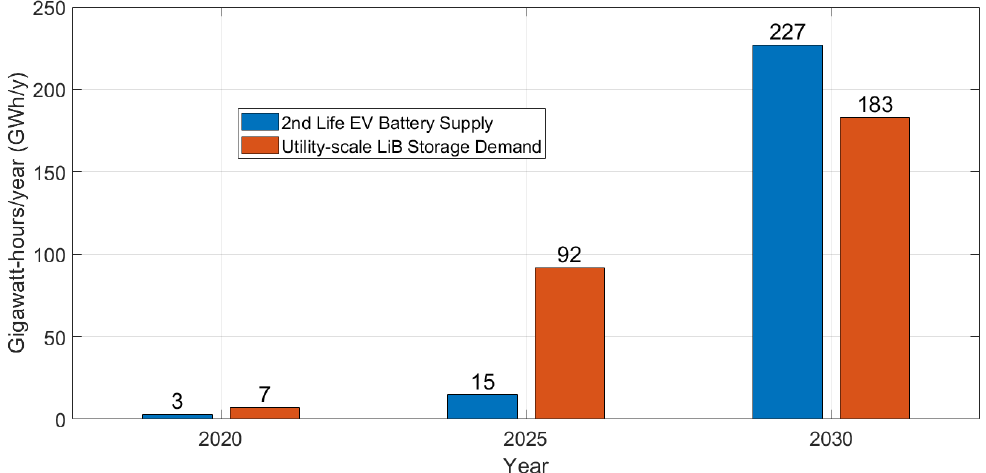
Figure 8. Estimated SLB from passenger car supply and utility demand change between 2020–2030